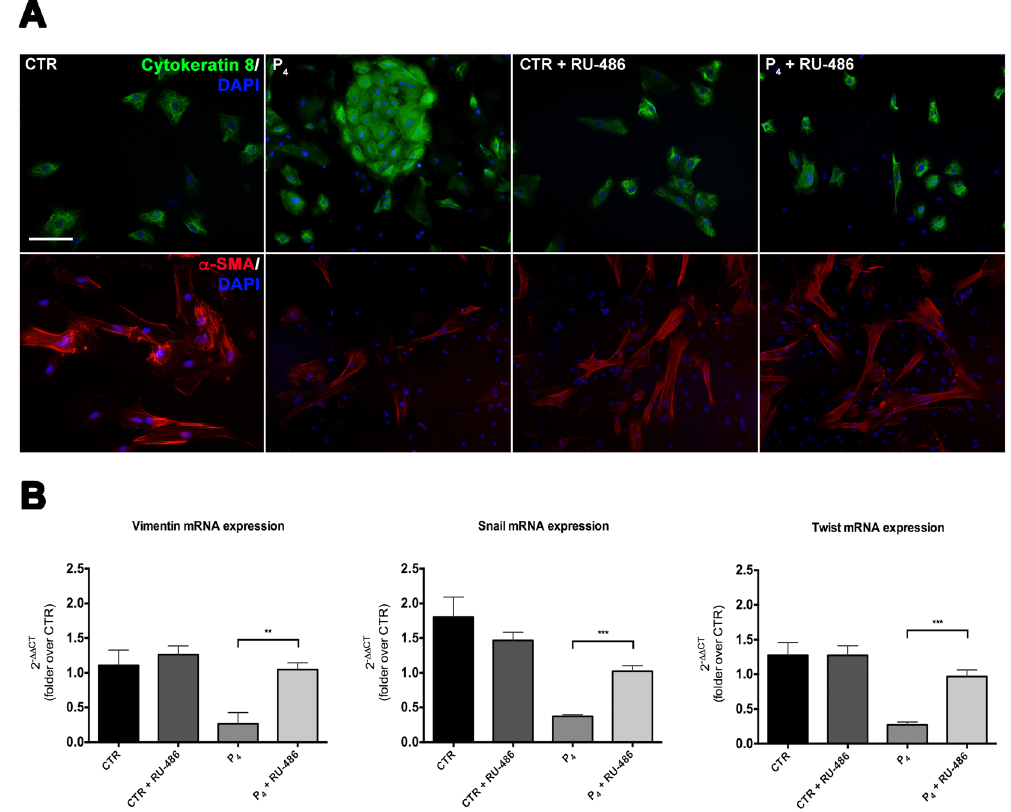
Figure 3. RU-486 (mifepristone) prevents the effect of P 4 on EMT. ( A ) P 4 -treated oAEC exposed to RU-486 for 3 passages, progressively lost the Cytokeratine-8 positivity and increased the α -SMA expression as CTR cells. CTR exposed to RU-486 underwent EMT after 3 passages, and gained the expression of α -SMA. Scale bar: 50 µ m. ( B ) Real-time qPCR analysis of EMT-related genes Vimentin , Snail and Twist . Data are the mean ± SEM, from n = 3 independent experiments performed in triplicate. * p < 0.05, ** p < 0.01. Abbreviation: CTR, control cell; P 4 , progesterone; RU-486,